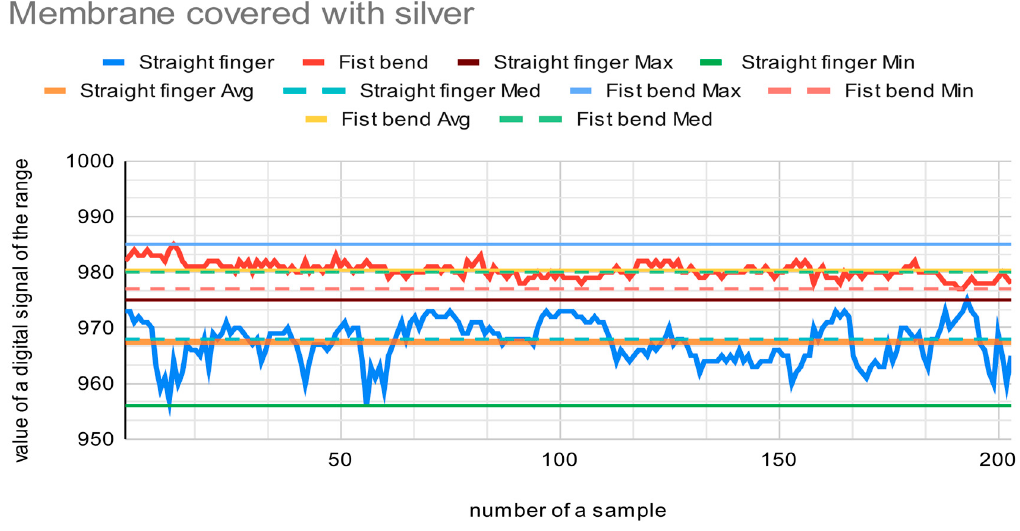
Figure 11. Chart showing samples collected with the Goretex membrane covered with silver material as a core for the bend sensor. Table 2. Encoded analog signal at levels from 0 to 1023. S—straight finger; B—bent finger.